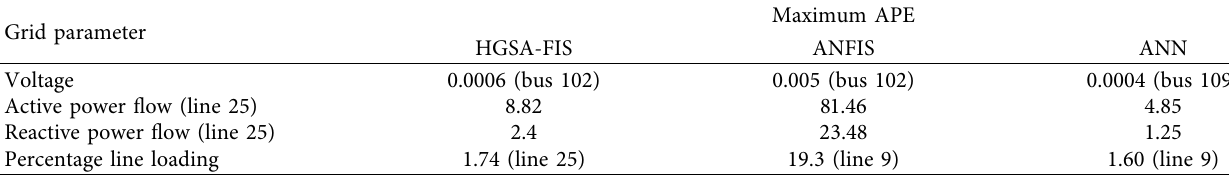
Table 5: Maximum deviation of HGSA-FIS-, ANFIS-, and ANN-based equivalents.